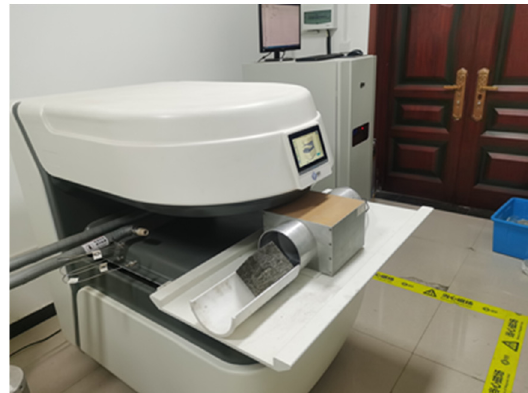
Figure 2. LF-NMR test blocks.